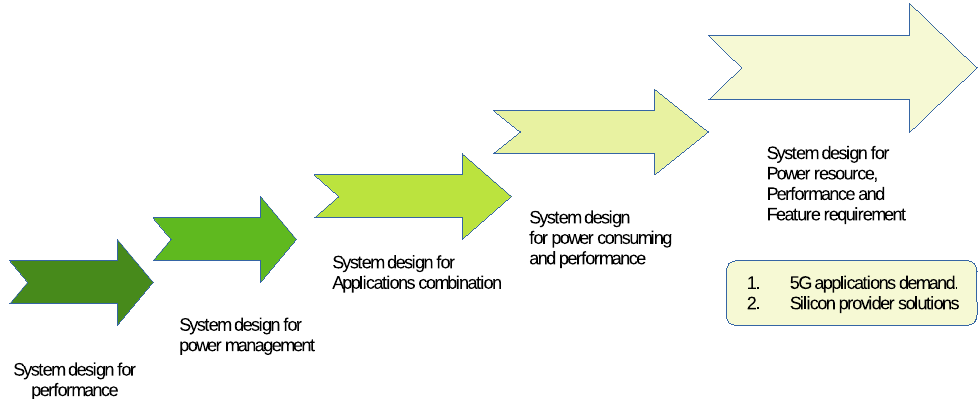
Figure 16. Technology strategy roadmap for PC